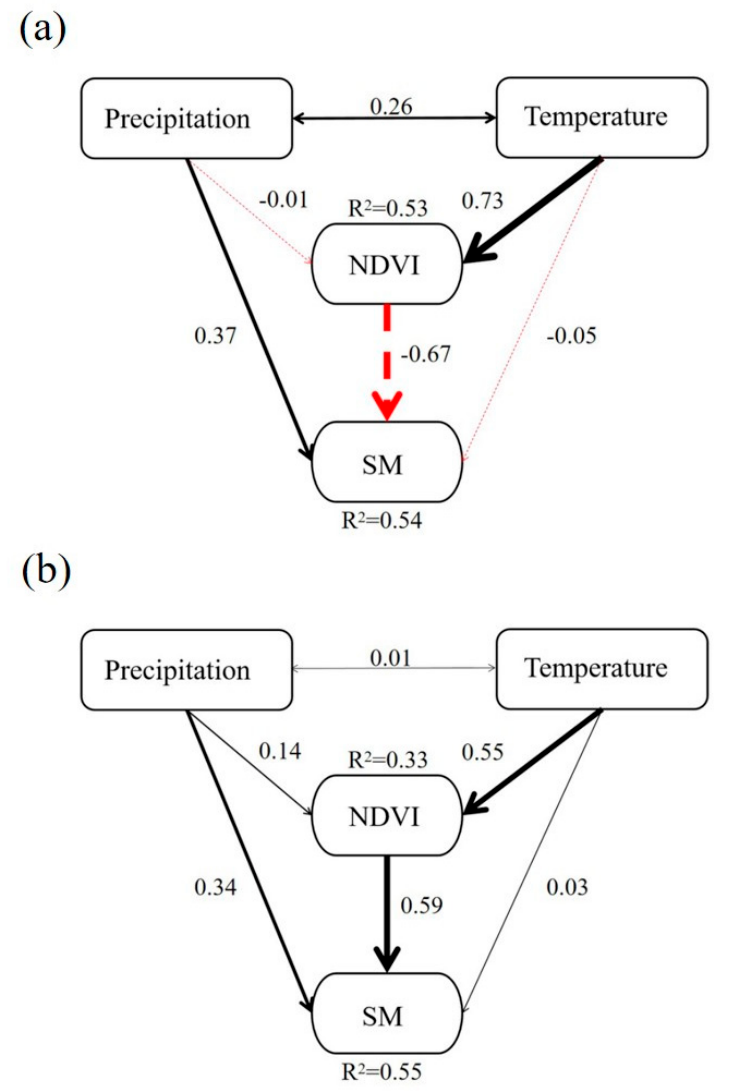
Figure 8. Results of structural equation modeling of the relationship between NDVI, precipitation, temperature, and SM in the ( a ) soil drying zone and the ( b ) soil wetting zone. A solid black line indicates a positive coefficient, a dashed red line indicates a negative coefficient and the thickness of the line indicates the absolute value.